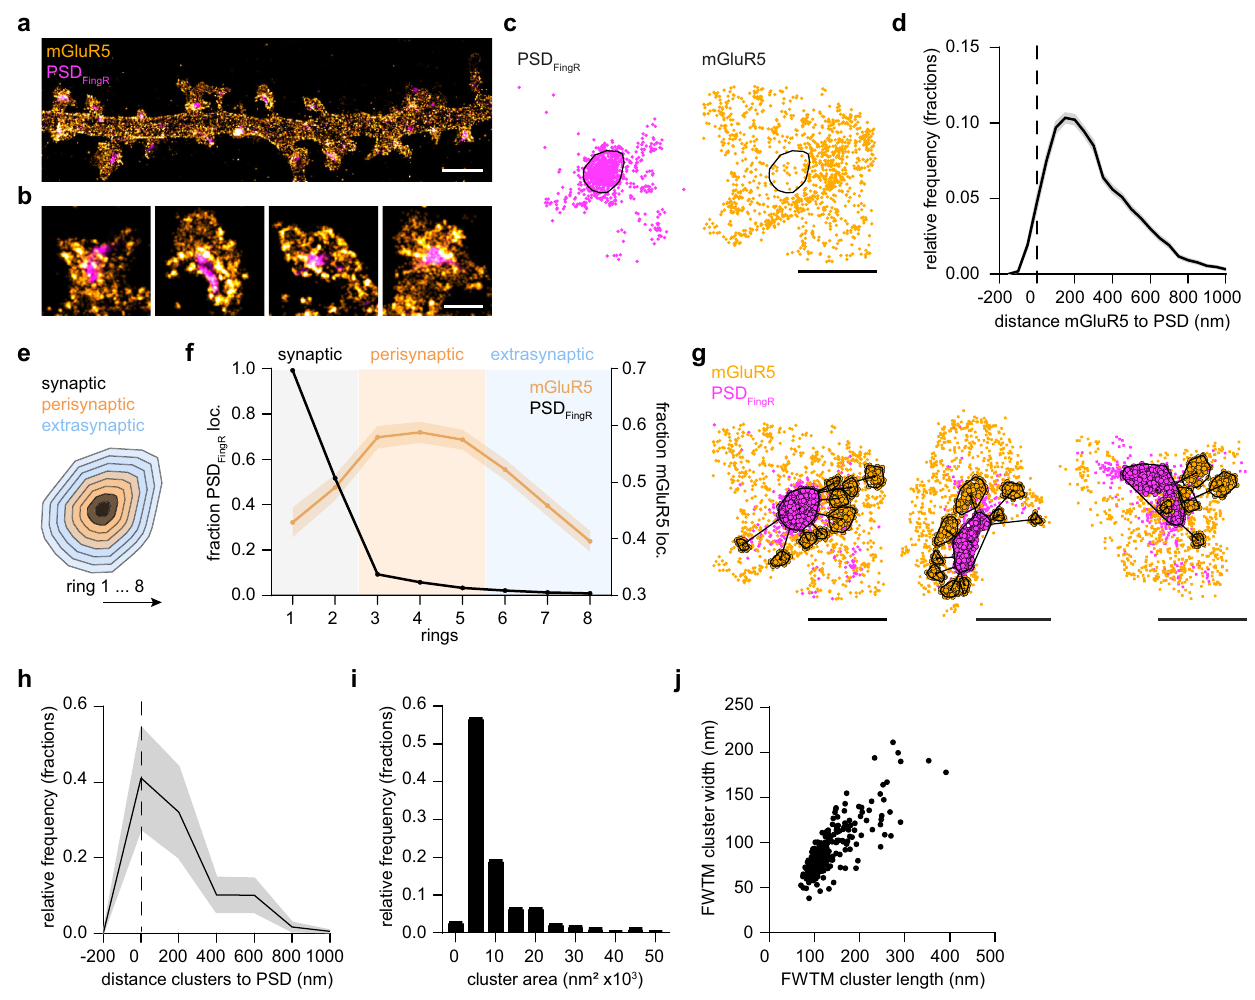
Fig. 2 | mGluR5 is organized in perisynaptic nanodomains. a Reconstruction of single-molecule localizations obtained for SEP-mGluR5 anti-GFP nanobody Alexa647 using dSTORM (orange hot) and PSD FingR -mEos3.2 using PALM (cyan hot).SamedendriticregionisshowninFig.S2a.Scalebar,2 µ m. b Zoomsofspines shown in a . Scale bar, 500nm. c Representative spine with single-molecule loca- lizations of PSD FingR (cyan)and mGluR5(orange)withindicated PSD border (black line) determined using DBScan. Scale bar, 500nm. d Relative frequency distribu- tion (fractions) of the distance of individual mGluR5 localizations to the PSD border ( n =13 neurons, 253 PSDs). e For each PSD, eight rings, proportionally scaled based on its PSD border, de fi ned the synapse (ring 1 and 2; black), perisy- napticzone(ring3 – 5;orange),andextrasynapticregion(ring6 – 8;blue). f Fraction